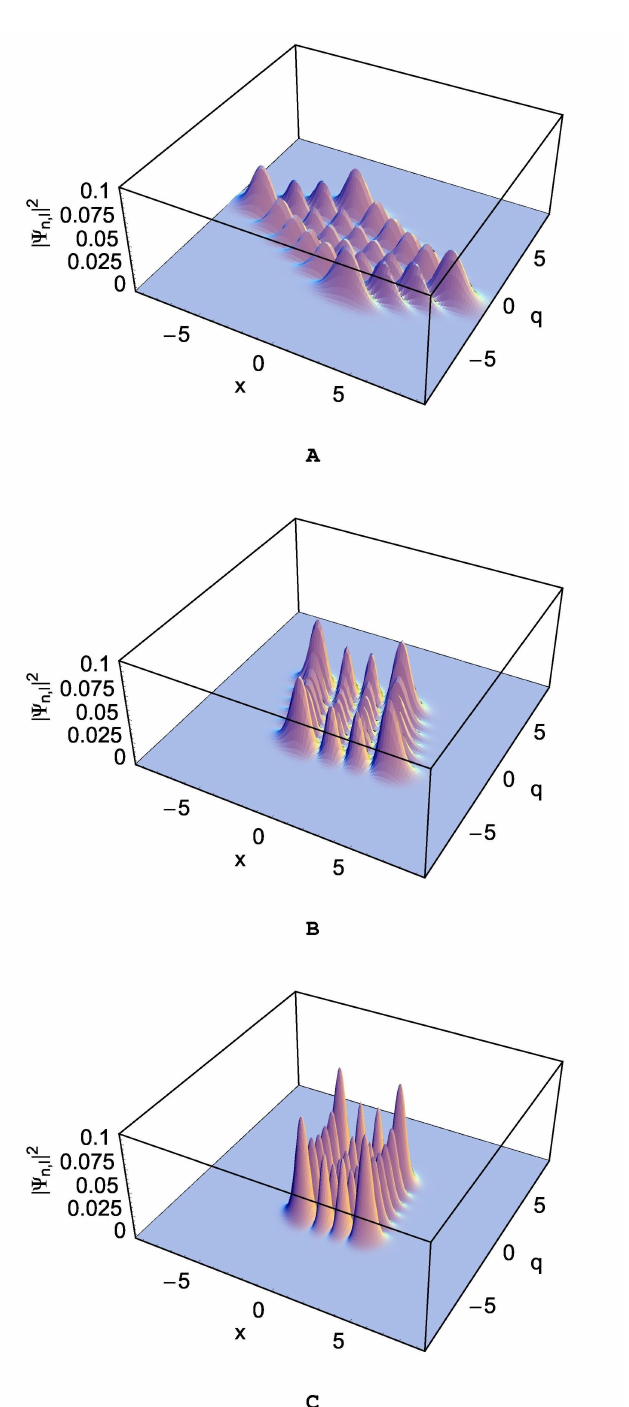
Figure 4. The probability density | Ψ n , l ( x , q , t ) | 2 in the original system for several different values of ω with the choice of ( m , L ) = (0.5, 2.0) under the limit λ ( t ) = λ 0 . This is associated to the wave functions given in Equation (19) with Equations (20), (21), (24), (25), (28), and (29). The values of ( ω , Ω ) are (0.5, 0.49) for ( A ), (1.0, 0.49) for ( B ), and (2.0, 0.49) for ( C ). We used ( n , l ) = (3, 5), ¯ h = 1, and λ 0 =